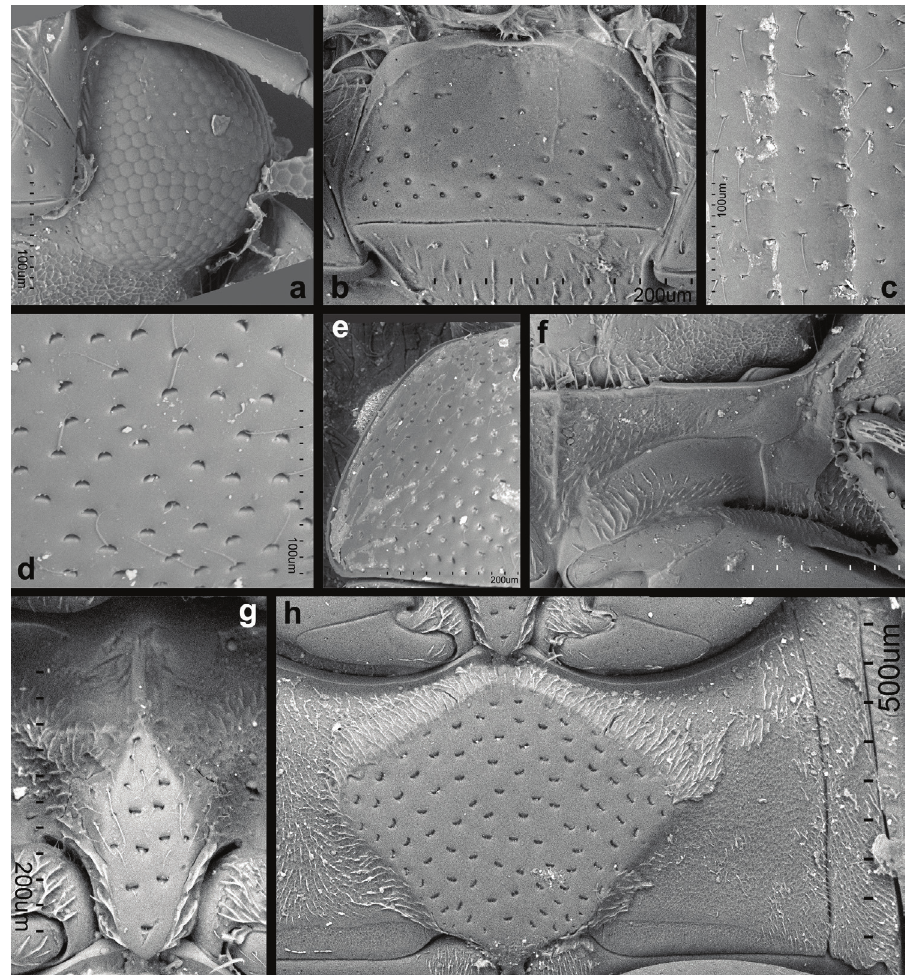
Figure 7. Cercyon ( Acycreon ) punctiger Knisch a ventral view of eye b labium c detail of elytral surface d detail of head surface e detail of pronotal surface and lateral margin f prosternum g mesoventral plate h